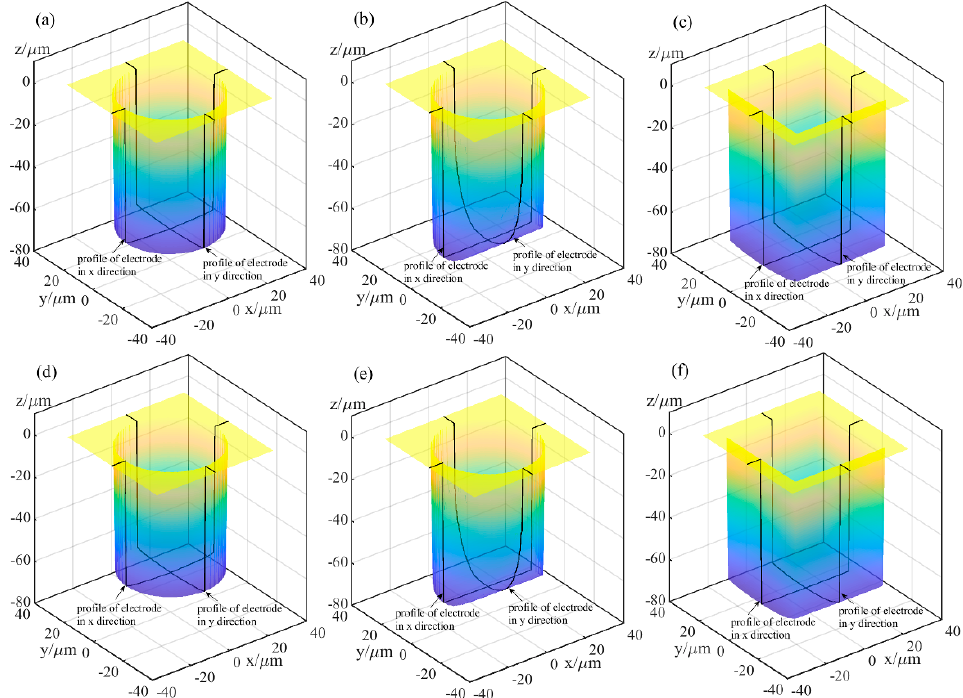
Figure 10. Simulation machining results of the tool electrodes: ( a ) cylindrical electrode-rotating mode-unidirectional path; ( b ) cylindrical electrode-nonrotating mode-unidirectional path; ( c ) square electrode-nonrotating mode-unidirectional path; ( d ) cylindrical electrode-rotating mode-reciprocating path; ( e ) cylindrical electrode-nonrotating mode-reciprocating path; ( f ) square electrode-nonrotating mode-reciprocating path.